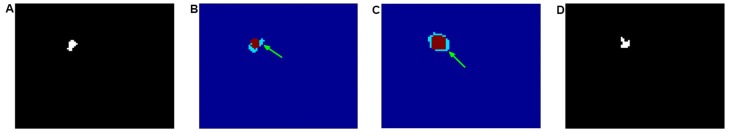
Plots showing the correlation between of average intensity and two qualitative metrics for images obtained at different time frames.(A)-(E): Illustration of the DIF/REC ratio (red dash dot curve), OVL/REC ratio (green dash curve) and averaged intensity (blue curve) in the tumour region of interest across for the five tumour cases considered. The x-axis labels the six different time steps, and the y-axis labels the scaled value of each ratio and intensity.